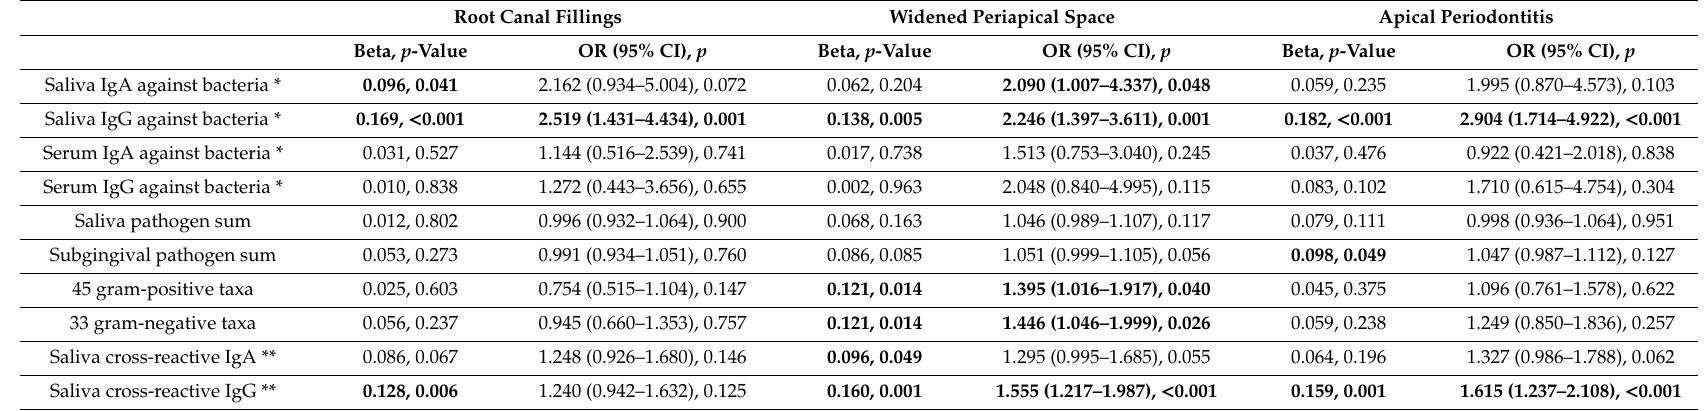
Table 2. Associations of endodontic findings with saliva and serum antibody levels and bacterial